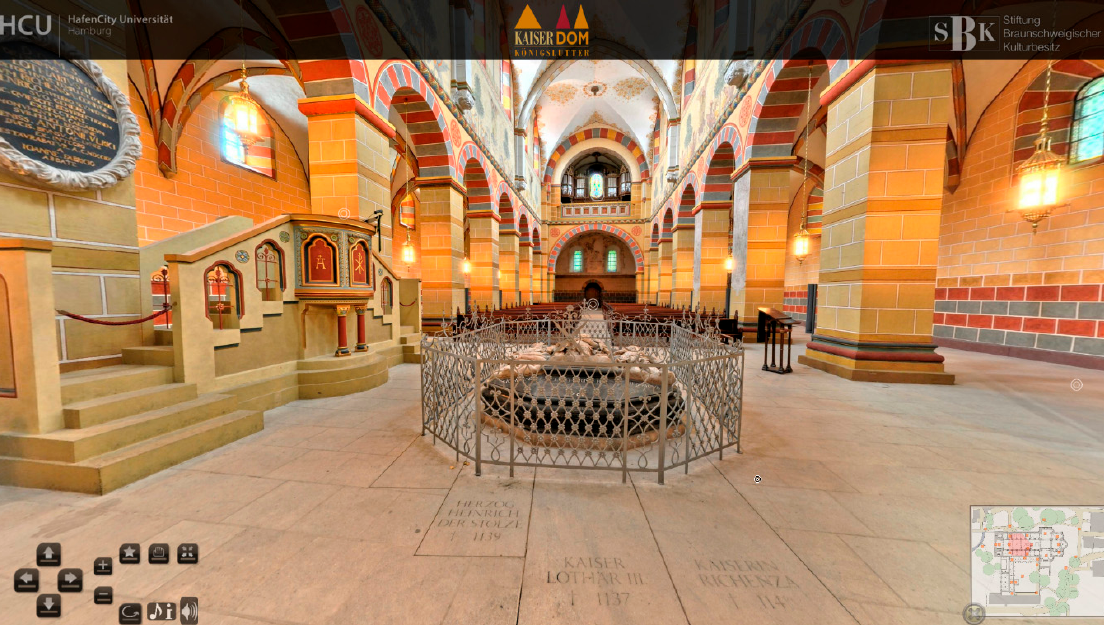
Figure 6. Interactive virtual tour through the imperial cathedral using full spherical panorama photography on several stations inside and outside of the building, including an overview map of stations (bottom-right corner).